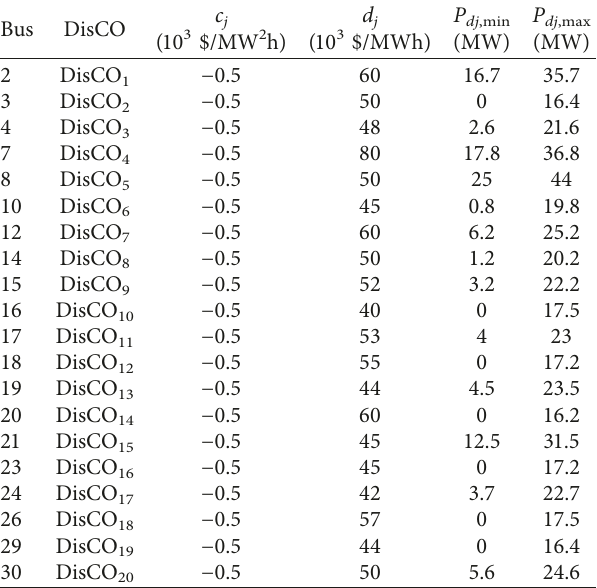
Table 4: Parameters of DisCOs’ bid functions.